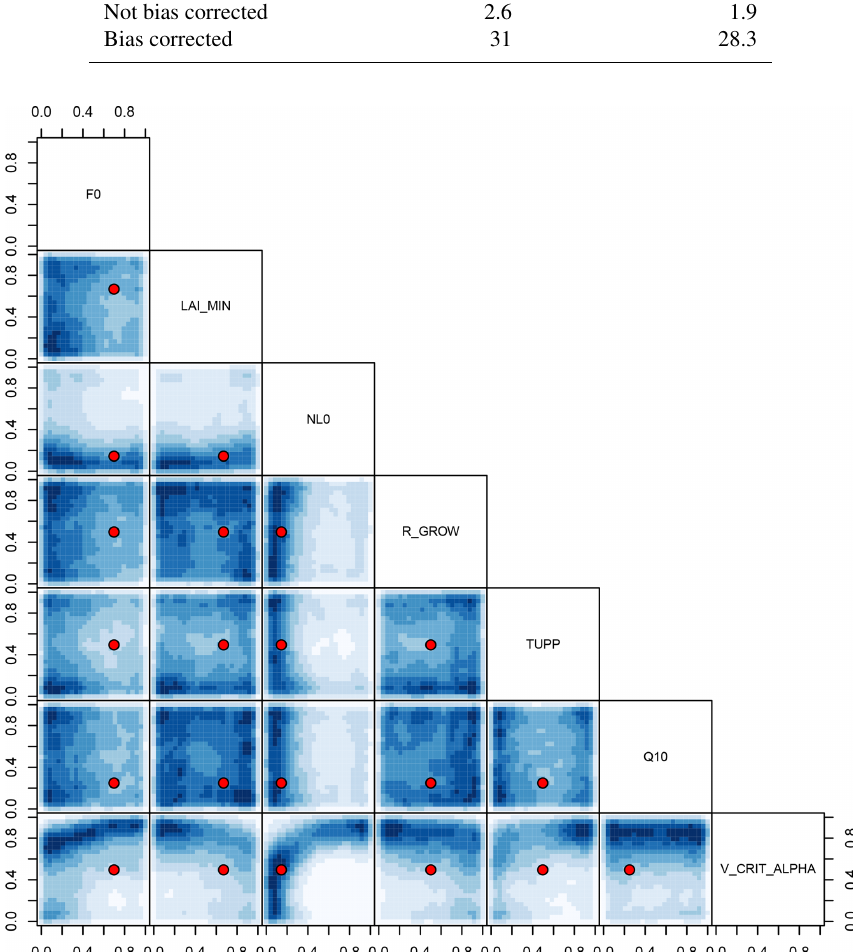
Figure 12. NROY land surface input space shared by all three forests when bias corrected using the augmented emulator. Blue shading denotes the density of NROY input candidates, projected into the two-dimensional space indicated by the labels. The default parameter settings are marked as red